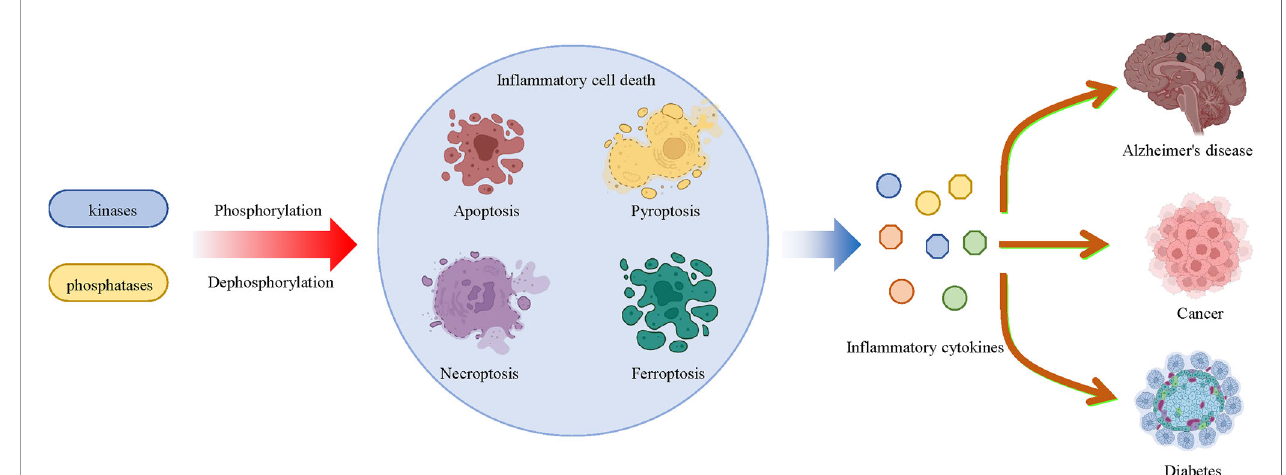
FIGURE 5 | Multiple kinases and phosphatases regulate in fl ammatory cell death and related diseases through phosphorylation and dephosphorylation modi fi cations. Multiple protein kinases that mediate phosphorylation and phosphatases that mediate dephosphorylation affect the pathologic development of a large number of in fl ammatory diseases, including diabetes, Alzheimer ’ s disease and cancer by regulating in fl ammatory cell death, such as apoptosis, pyroptosis, necroptosis and ferroptosis, and in fl ammatory cytokine